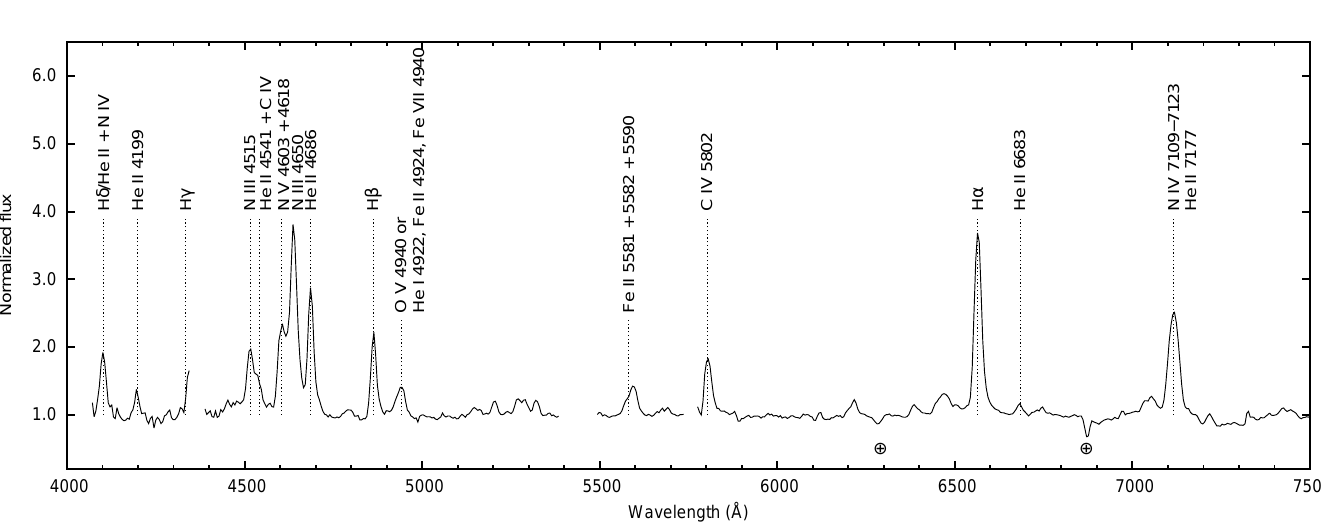
Figure 2: First spectrum of T Pyx on t = 0 . 19 d. The highly excited emissions were detected likely to Wolf-Rayet stars. Cross circles denote positions of telluric absorption bands.